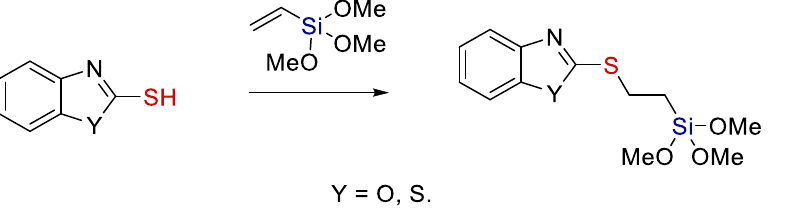
Figure 11. The synthesis of organosilicon derivatives of 2-mercaptobenzoxazole and 2-mercapto- benzothiazole [31].